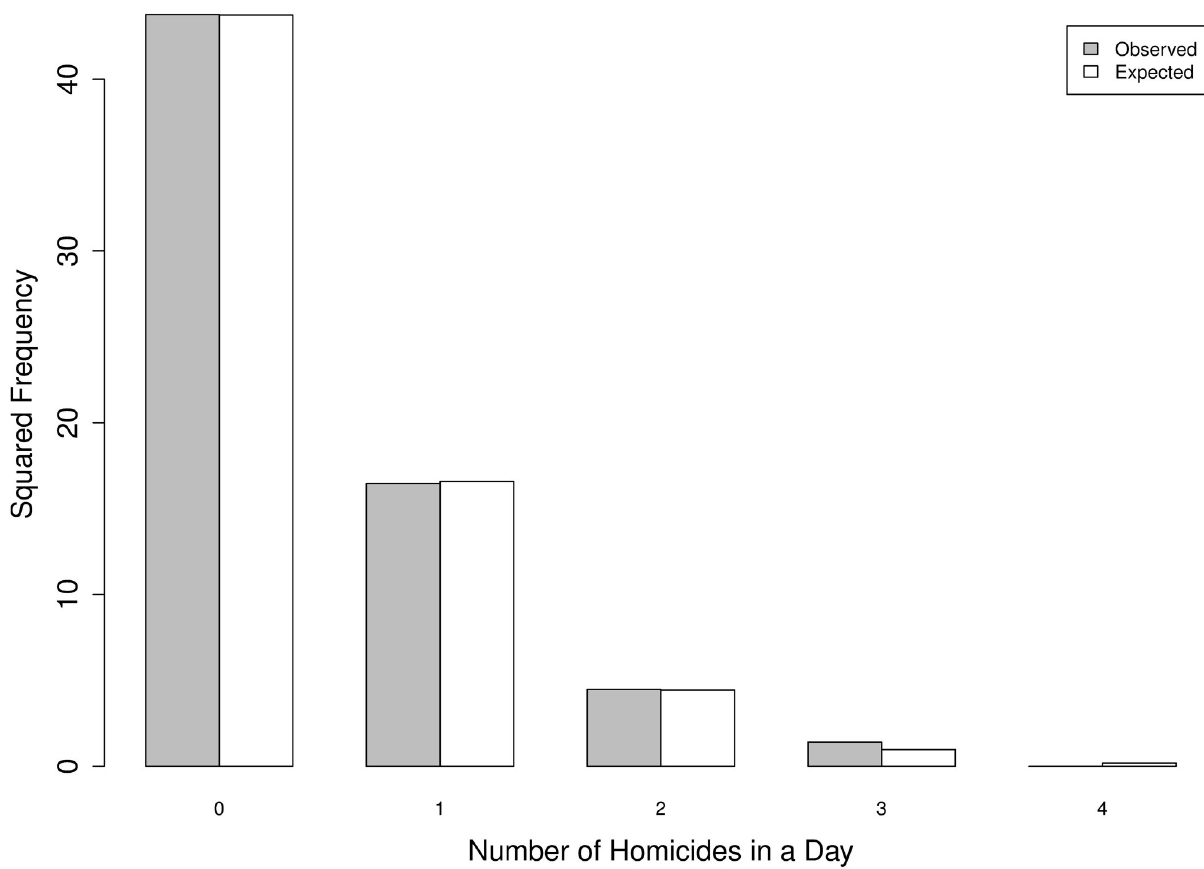
Fig 6. IPHs per day: Square root of frequencies observed from N 1 ( t ) (gray) and expected (white) from a Poisson process.